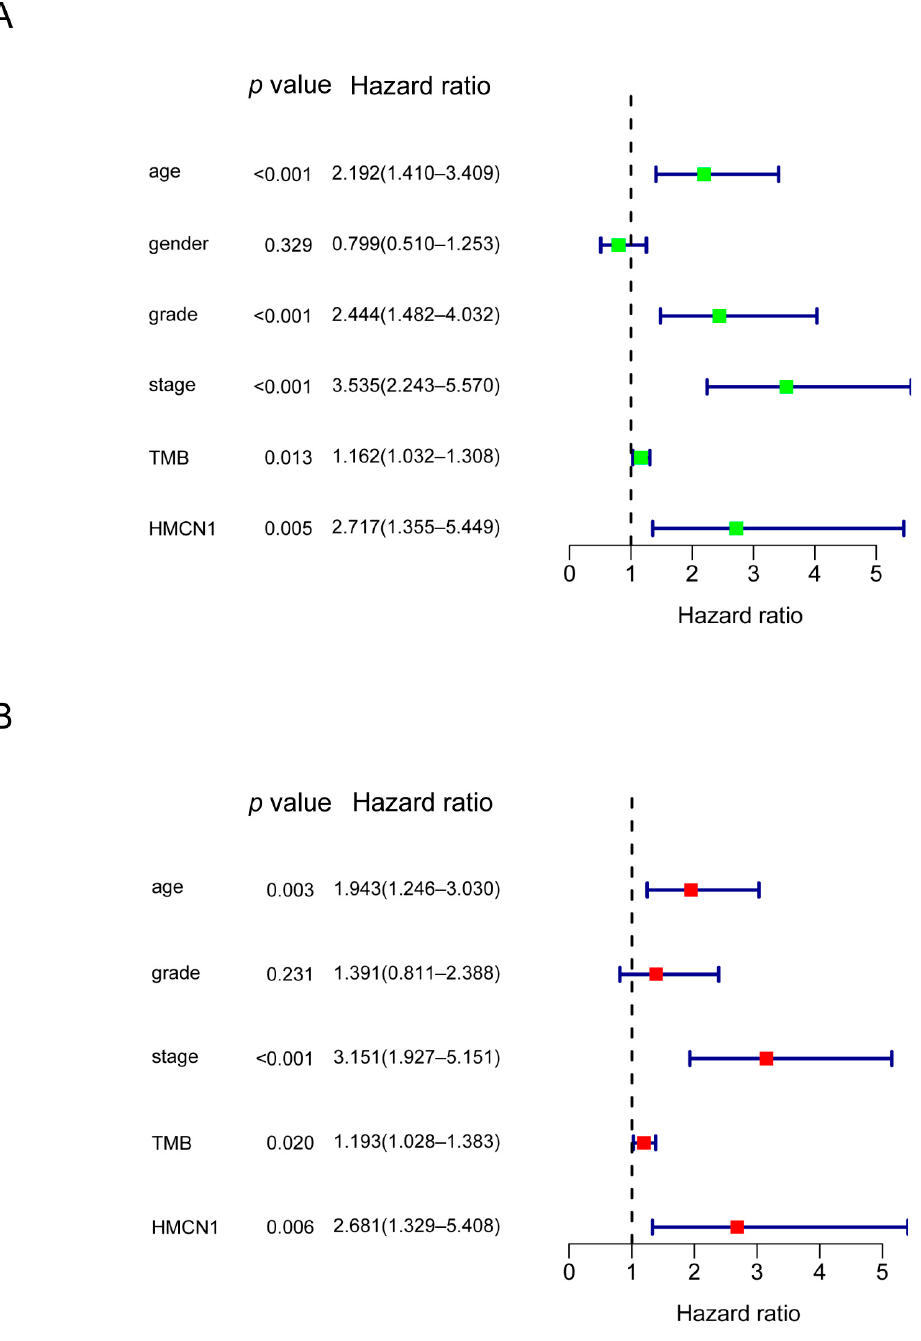
Figure 5. Univariate ( A ) and multivariate ( B ) Cox regression model of KIRC.